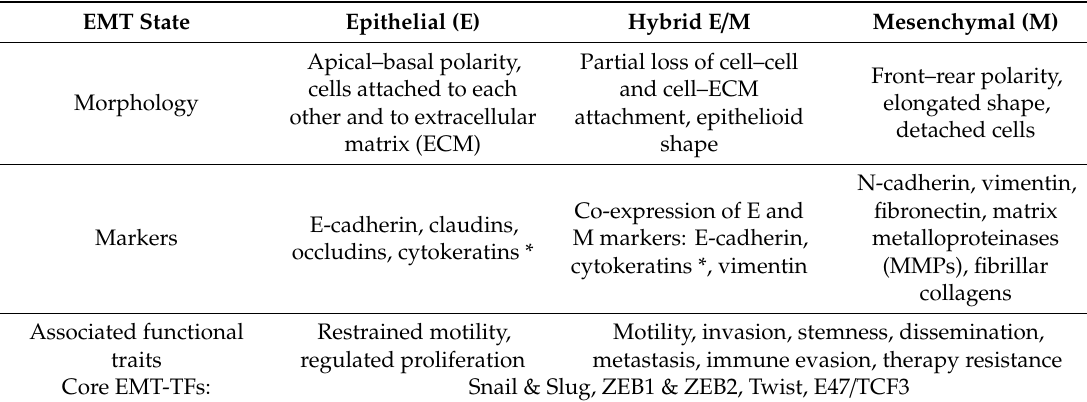
Table 1. EMT-TFs and main characteristics associated with the EMT